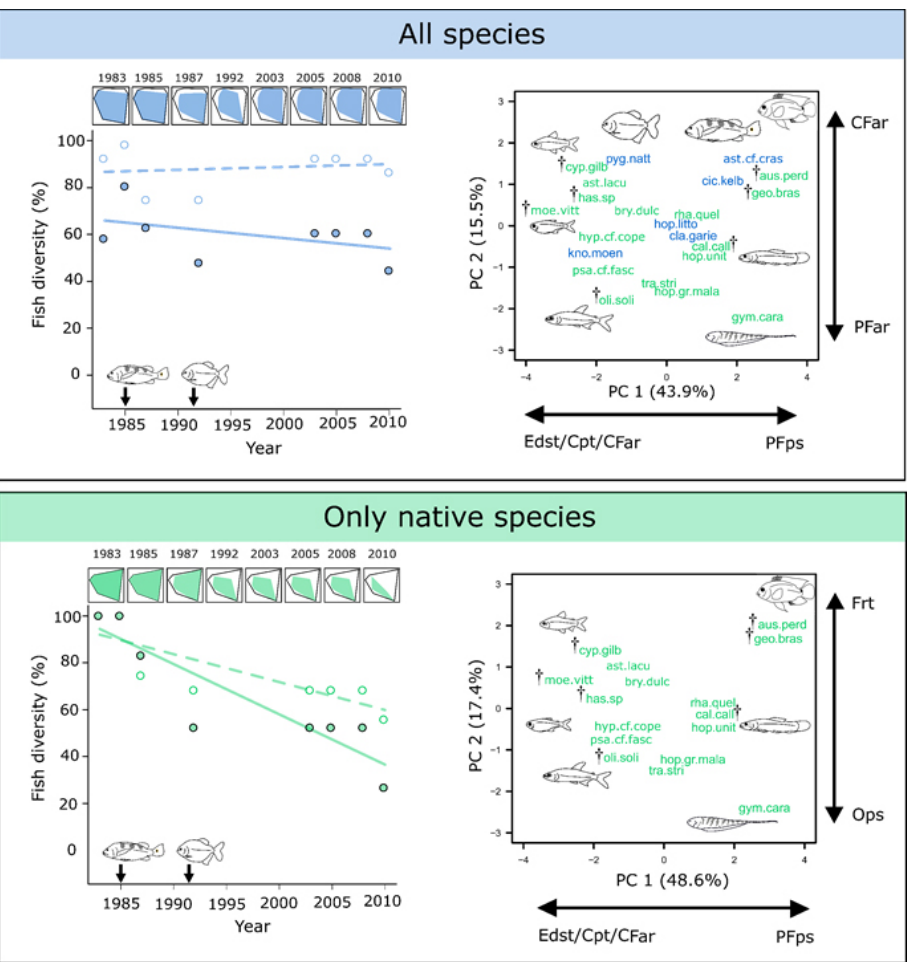
FIGURE 4 | Temporal changes in species richness (dashed lines) and functional richness (FRic; continous lines) of the ichthyofauna from Carioca Lake, Middle Rio Doce basin, state of Minas Gerais, considering two scenarios: “all species”, including native and non-native; and “only native species” (left figures). Plotted values expressed as a proportion to the maximum richness. The arrows represent the first records of the introduced piscivorous Cichla kelberi (in 1985) and Pygocentrus nattereri (in 1992) in the system. The upper plots represent the functional space (only two dimensions for simplify visualization), with polygons indicating the proportion filled by the set of species (FRic) in each year. Right figures illustrate the functional space showing the position of each species. Green and blue colors indicate, respectively, the native and introduced species, and crosses indicate native species extirpated from the lake. Codes at the ends of the arrows are the most important ecomorphological traits for each axis of the PCA (for functional trait and species codes, see Tab. 1 and Tab. S2